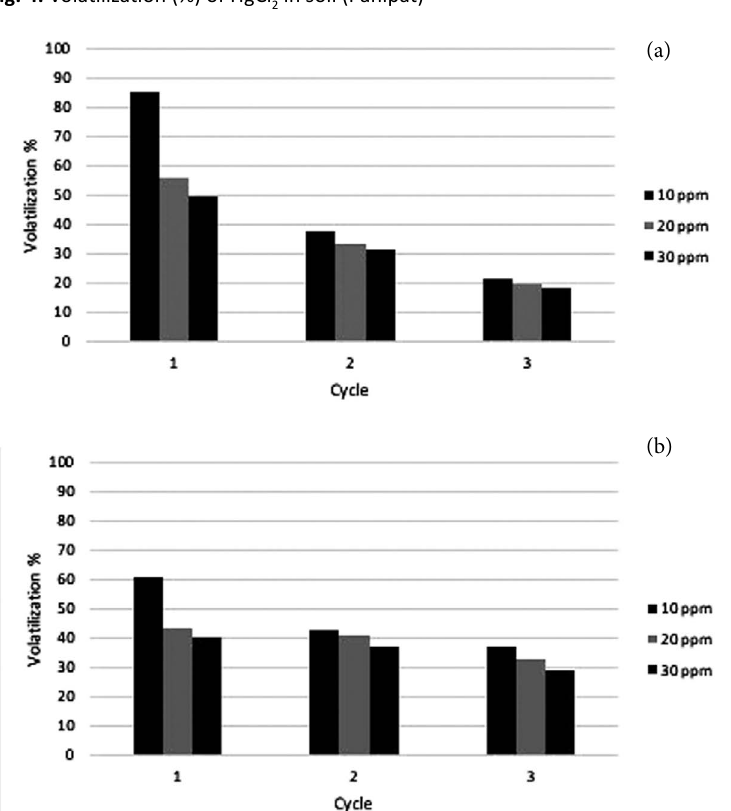
Fig. 4. Volatilization (%) of HgCl